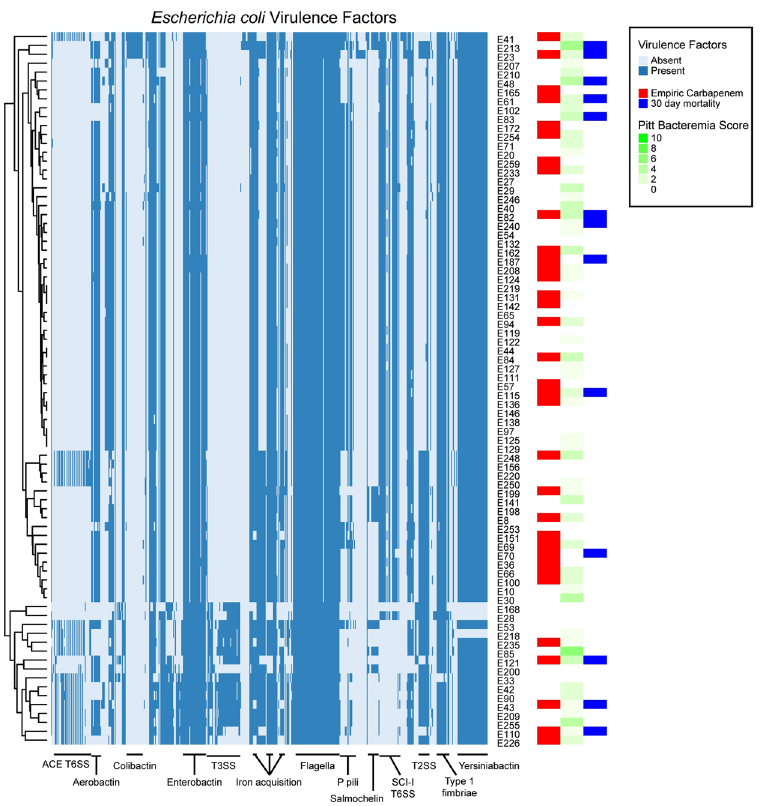
Figure 3. Heatmap of virulence factor calls from based on raw read mapping to VFDB for K. pneumoniae strains. Each row represents one K. pneumoniae strain, as indicated on the right of the heatmap. The strains are clustered based on their virulence factor profile, with the dendrogram displayed on the left. Each column represents one virulence factor, with selected general classes indicated below; a full list of virulence factors detected and their ordering in the heatmap can be found in Supplementary Table 1. Dark blue represents presence of a particular virulence factor in that strain; light blue indicates absence. Colored boxes on the right indicate empiric carbapenem, Pitt bacteremia score, and 30 day mortality associated with that